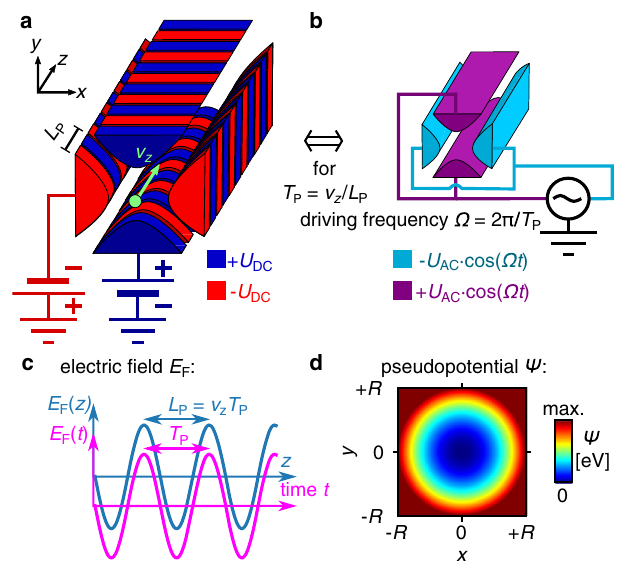
Fig. 1 Principle of auto-ponderomotive guiding. a When a beam of charged particles with velocity v z (green arrow) is injected into a structure consisting of electrostatic electrodes with spatially periodic voltages, the charged particle beam will be subjected to the equivalent transverse restoring force as charged particles in a linear electrodynamic trap with the same geometry, but with unsegmented electrodes as shown in b . This is because the spatially periodic electrostatic quadrupole fi eld with period length L P leads to an alternating fi eld with the periodicity T P = L P / v z in the rest frame of the moving particles ( c ). Like in a linear Paul trap, the charged particles experience a time-averaged harmonic pseudopotential, the ponderomotive potential, resulting in a restoring force towards the centerline. d The pseudopotential Ψ of both linear trap realizations shown in a and b can be made identical. R represents the electrodes ’ minimal distance from the guide ’ s